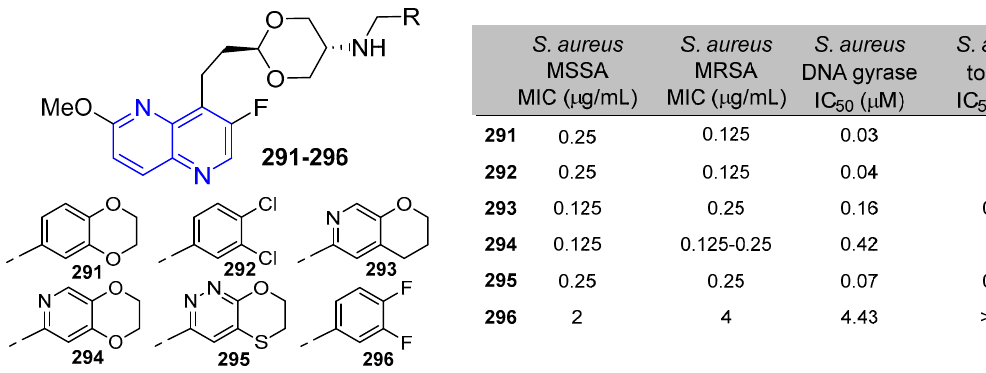
Figure 19. Antibacterial activity of dioxane-linked 1,5-naphthyridine derivatives.